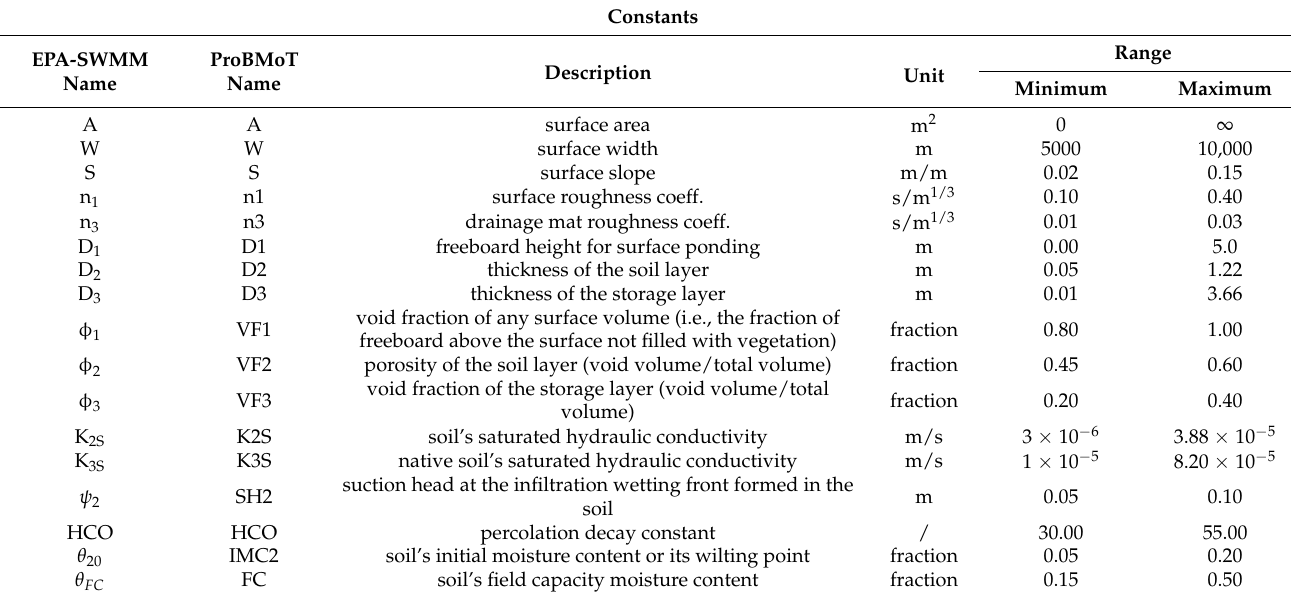
Table 5. Constants and their ranges used for stormwater control measures (entity